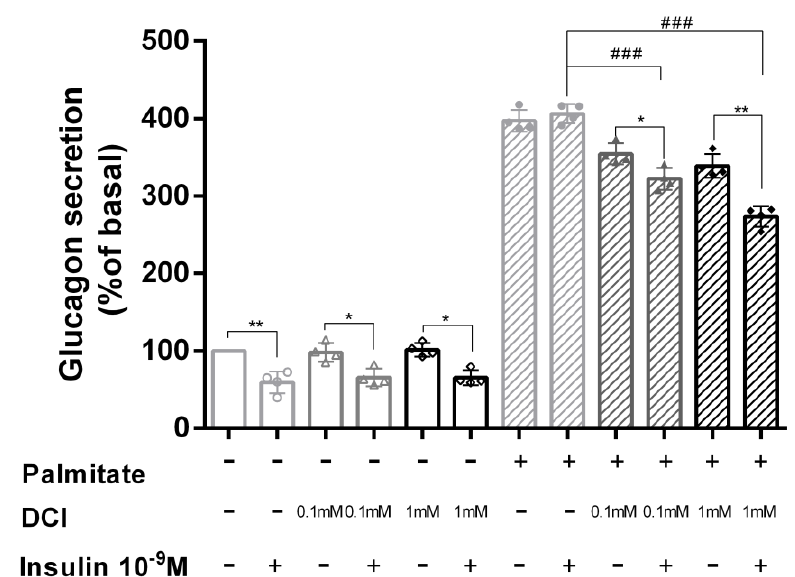
Figure 4. E ff ect of DCI on glucagon secretion in α -TC1-6 cells exposed to palmitate. Acute insulin inhibition of glucagon secretion in control cells and cells treated with 0.1 or 1 mM DCI in the presence or absence of palmitate (0.5 mM for 48 h) and / or insulin 10 − 9 M. Data represent four independent experiments. Student’s t-test was used to evaluate statistical significance in insulin-stimulated cells with respect to unstimulated cells in the absence and presence of palmitate (control: 1471 pg / mg protein ± 11 vs. control + Ins 10 –9 M: 870 pg / mg protein ± 10; palmitate: 5852 pg / mg protein ± 10 vs. palmitate + Ins 10 –9 M: 5976 pg / mg protein ± 9); * p < 0.05, ** p < 0.01. One-way ANOVA followed by Bonferroni test ( n = 4) was used to evaluate statistical significance in insulin-stimulated cells exposed to increasing DCI concentrations with respect to insulin-stimulated controls in the presence of palmitate. ### p < 0.001. n.s. not significant; DCI,